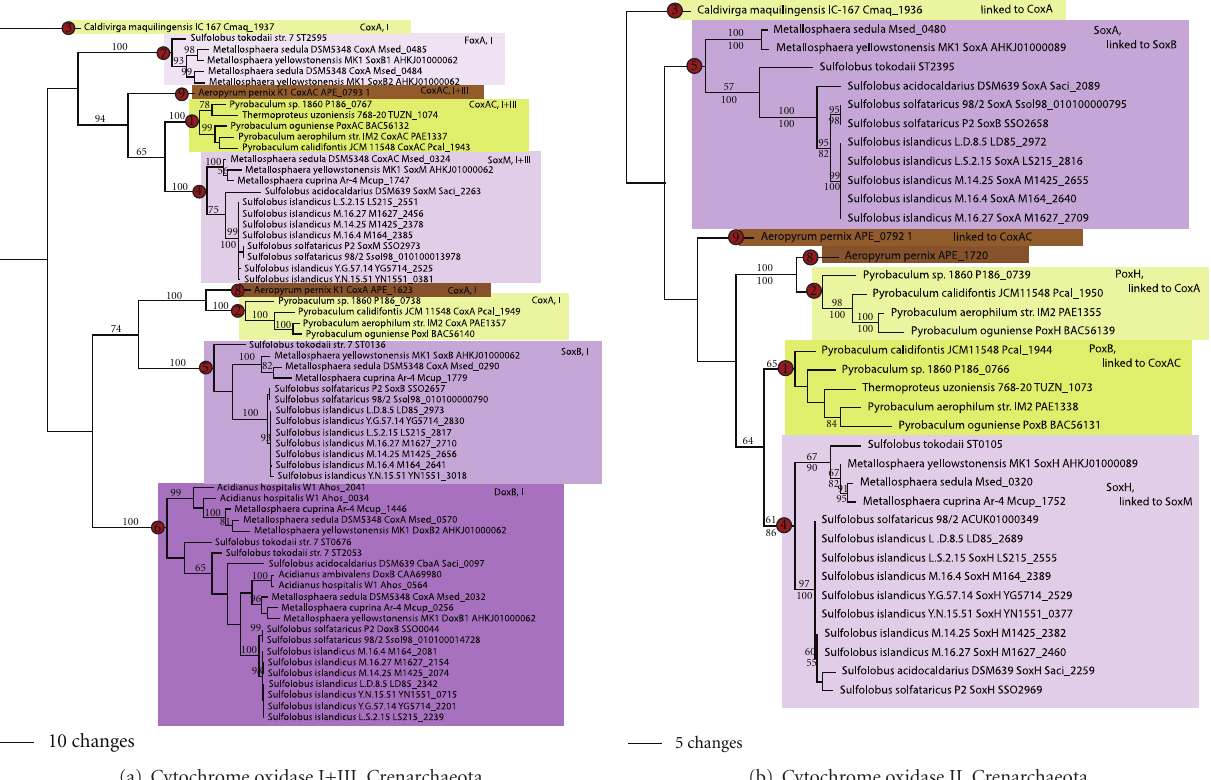
Figure 3: Cytochrome oxidase in the Crenarchaeota. Phylogenetic trees for (a) cytochrome oxidase subunit I and cytochrome oxidase subunits I+III and (b) cytochrome oxidase subunit II. Putative gene duplication events (e.g., leading to PoxB and PoxH) are indicated using black